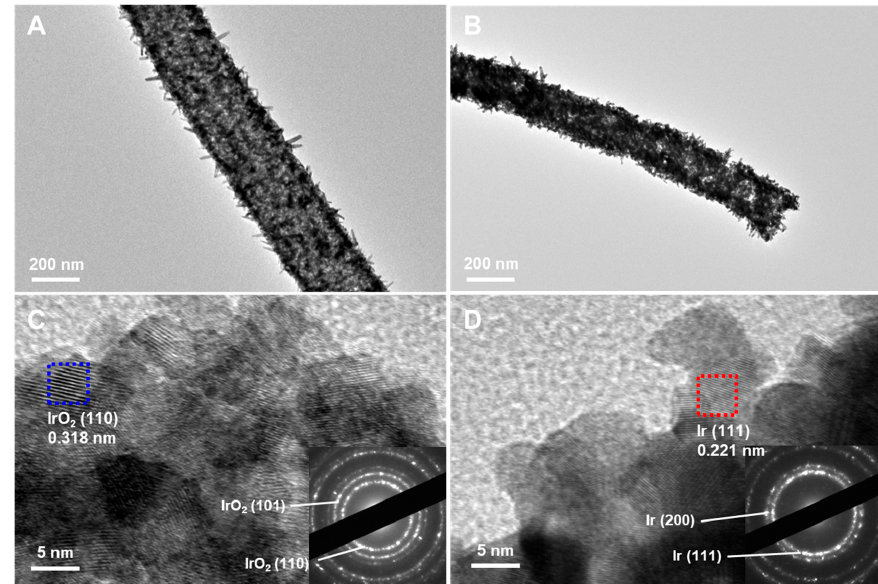
Figure 4. TEM images of ( A ) IrO 2 and ( B ) Ir metal nanotubes. HRTEM images of ( C ) IrO 2 and ( D ) Ir metal nanotubes (Insets: SAED patterns). metal nanotubes (Insets: SAED